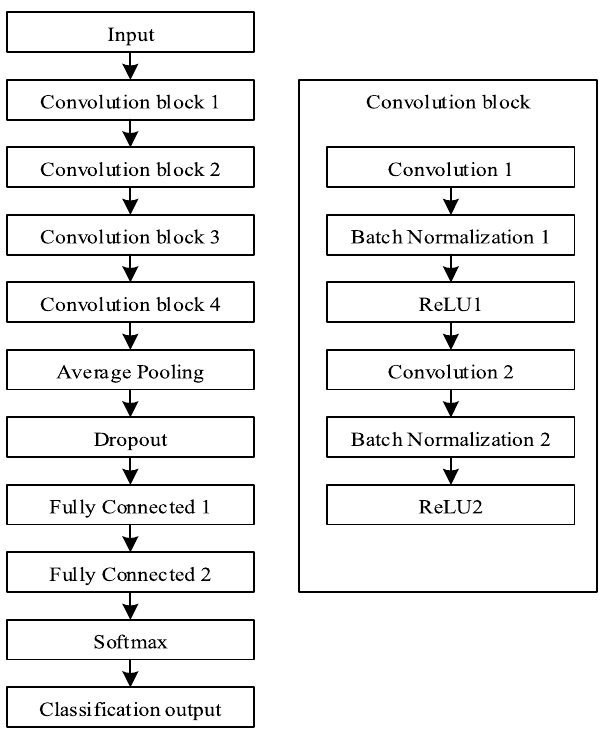
Figure 8. Convolution neural network (CNN) architecture of the proposed method.